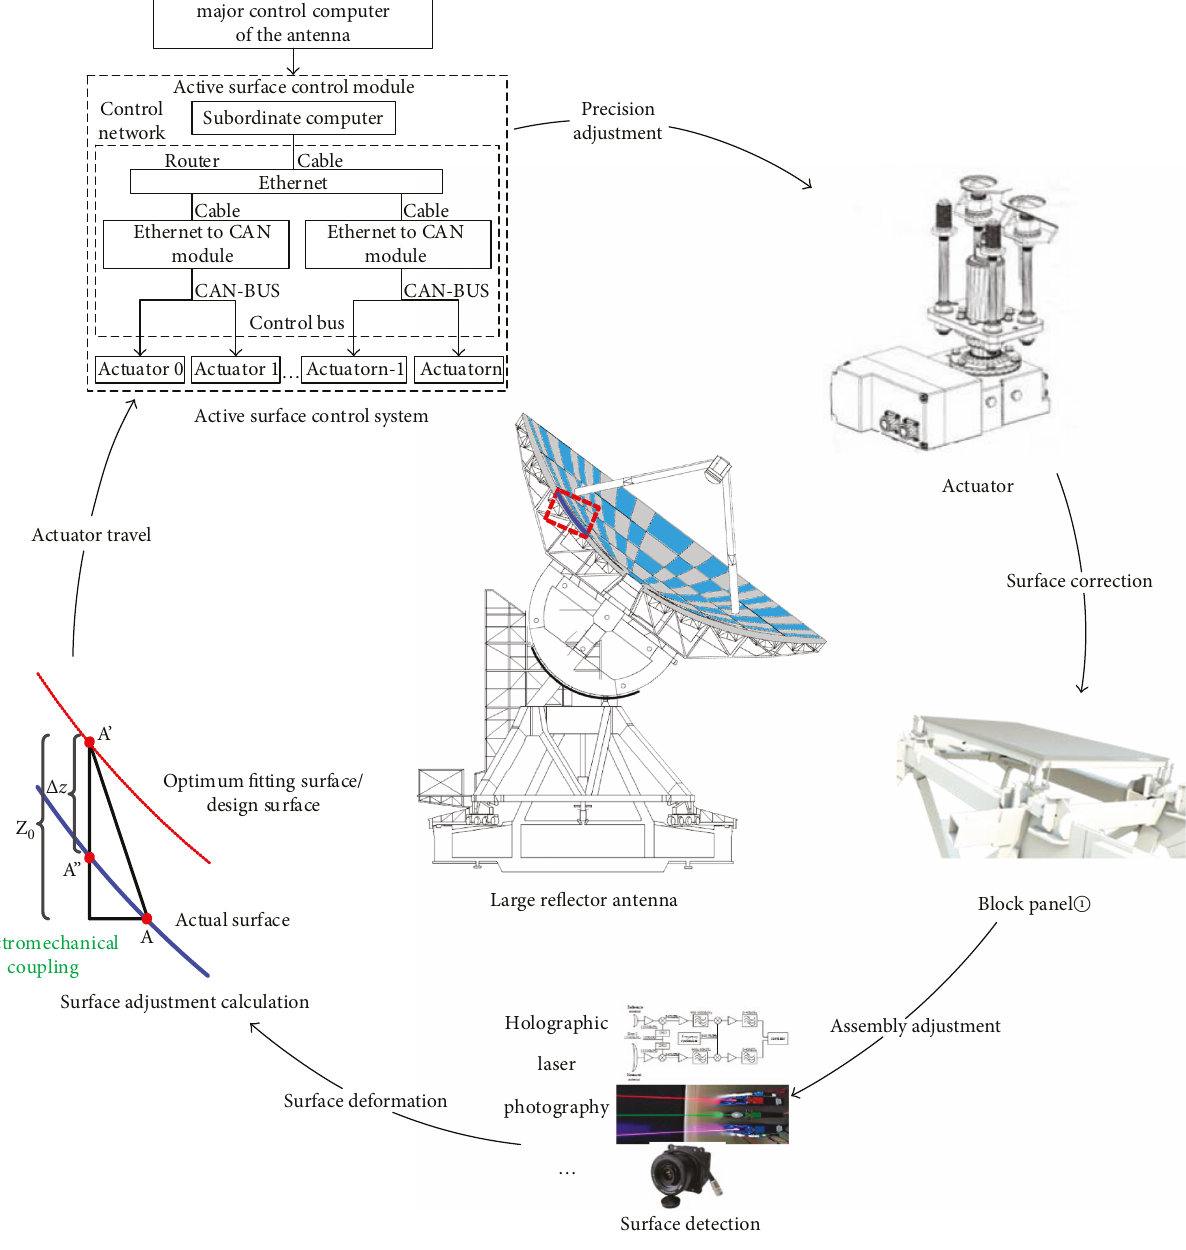
Figure 2: Process of active surface adjustment of large